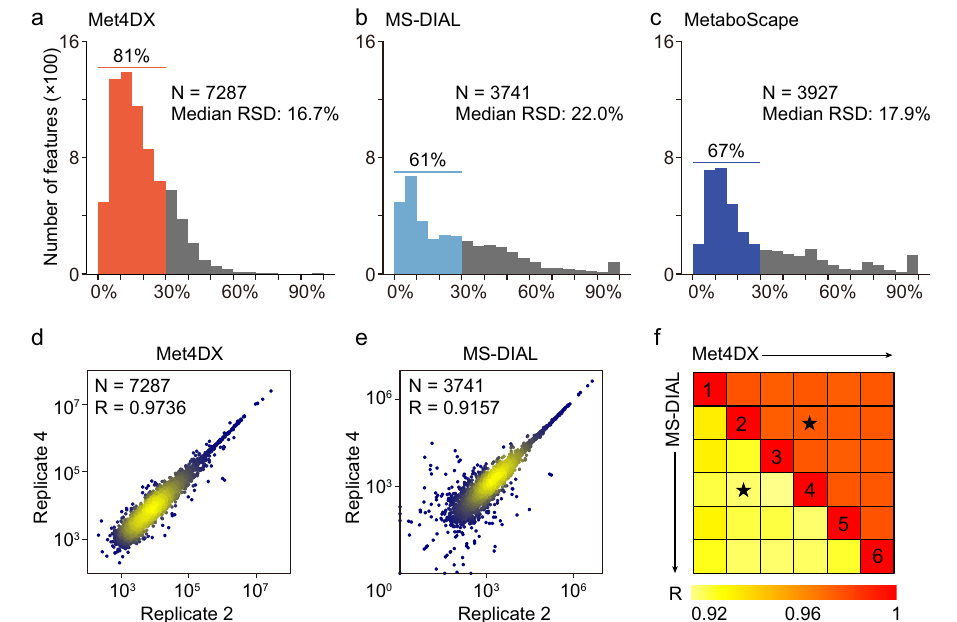
Fig.4|Highquanti fi cationprecisionof4Dpeakdetection.a – c Thedistributions of relative standard deviations (RSDs) of 4D peaks from human urine samples detected by Met4DX ( a ), MS-DIAL ( b ), and MetaboScape ( c ). d , e Log-log scatter plot of peak intensities between sample replicates 2 and 4 obtained from Met4DX ( d ) and MS-DIAL ( e ) for human urine samples. The color represents the peak